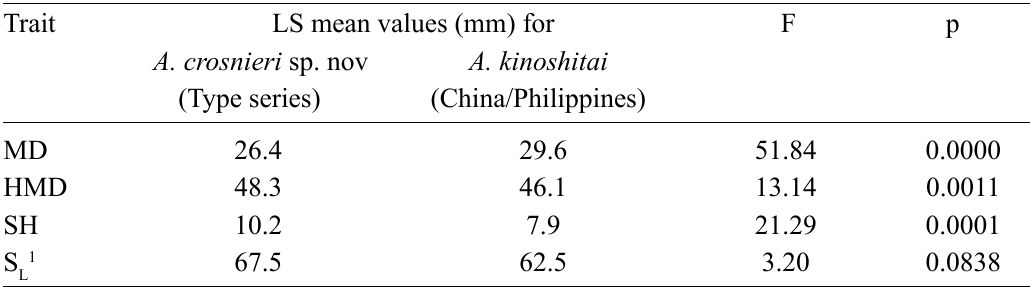
Table 2. Comparison between morphometric parameters for Afonsoconus crosnieri sp. nov. (N = 14) and A. kinoshitai (Kuroda, 1956) (N = 18): Least-squares (LS) means and ANCoVA results. 1 ANoVA results. For the pairwise comparison of mean S : t = 1.788, p = 0.084; u = 75.0, p = L